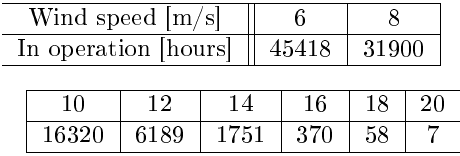
operation of 20